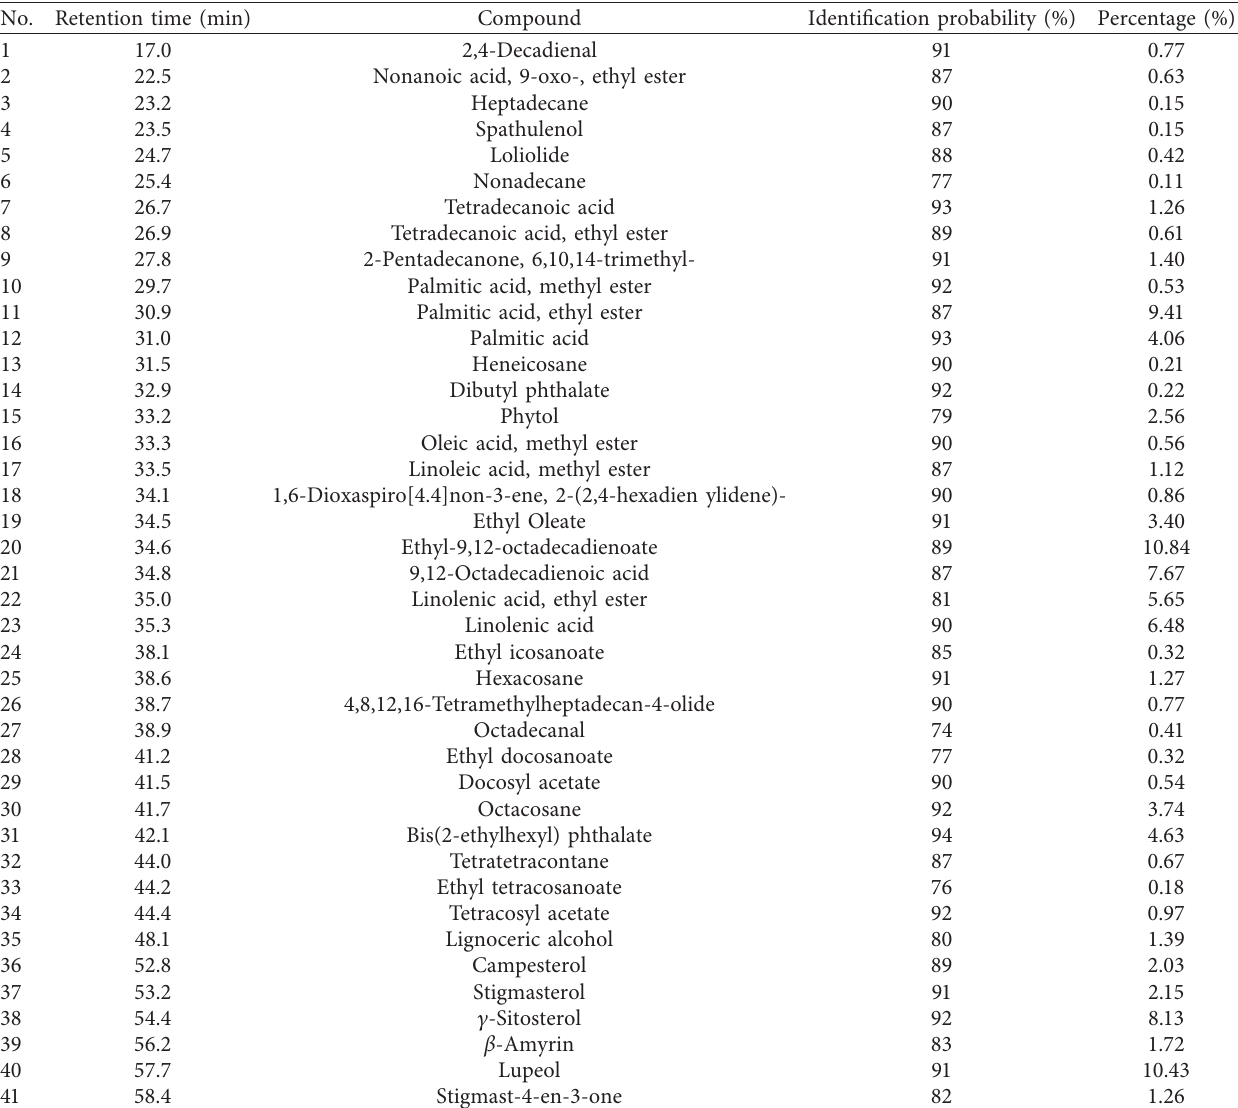
2 extract (Almaty region, Southeast Kazakhstan, 2018).